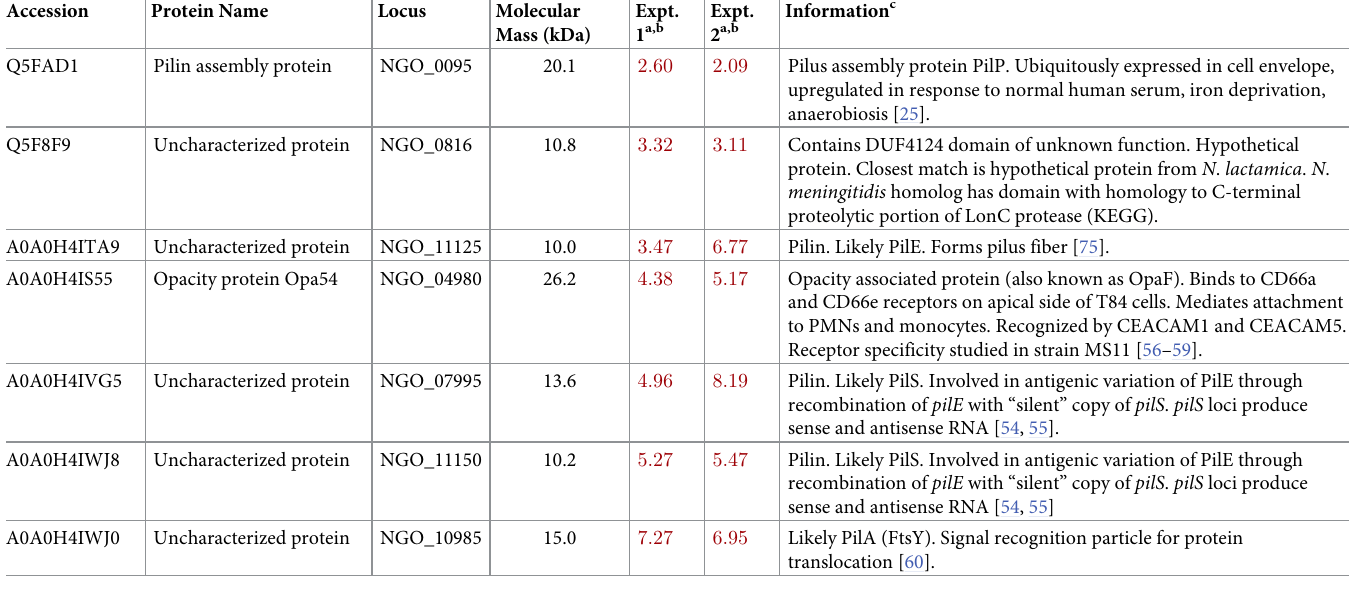
a Ratios represent fold change in each experiment. b Ratios for upregulated proteins are shown in red.